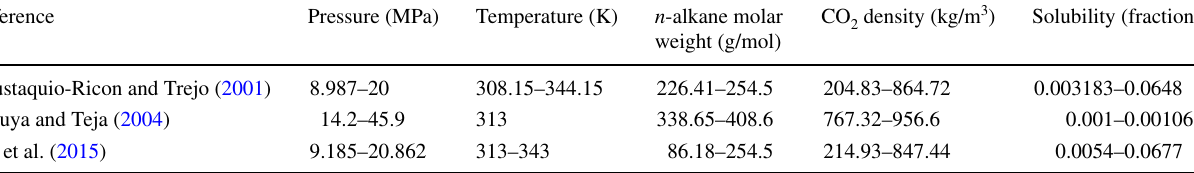
Table 1 Range of input and output parameters utilized in this study